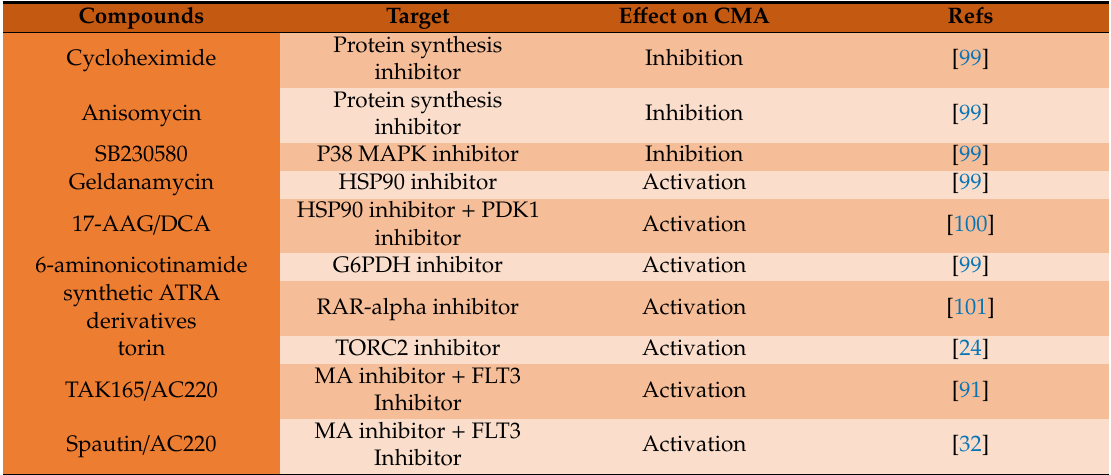
Table 2. Small molecule modulators of CMA